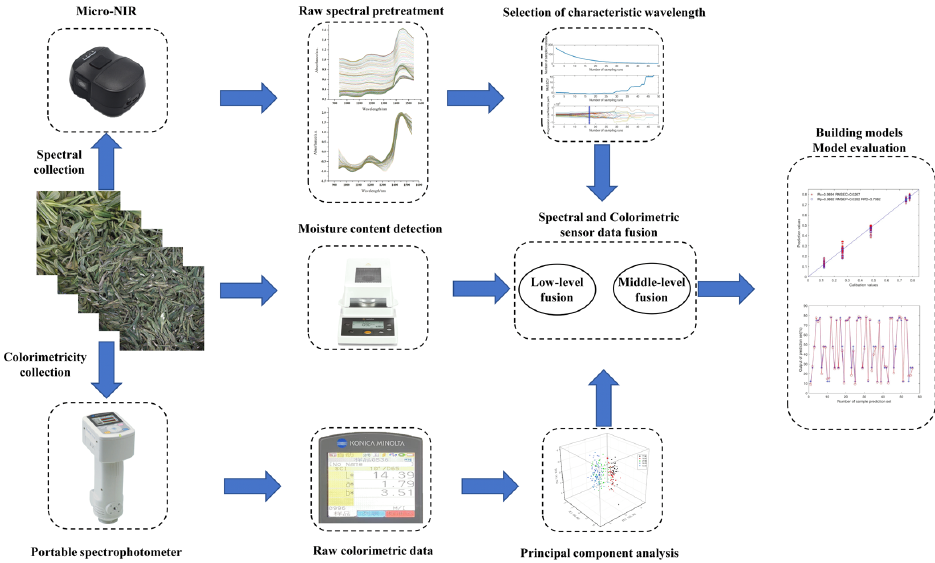
Figure 2. Flow diagram of the moisture content prediction experiment.